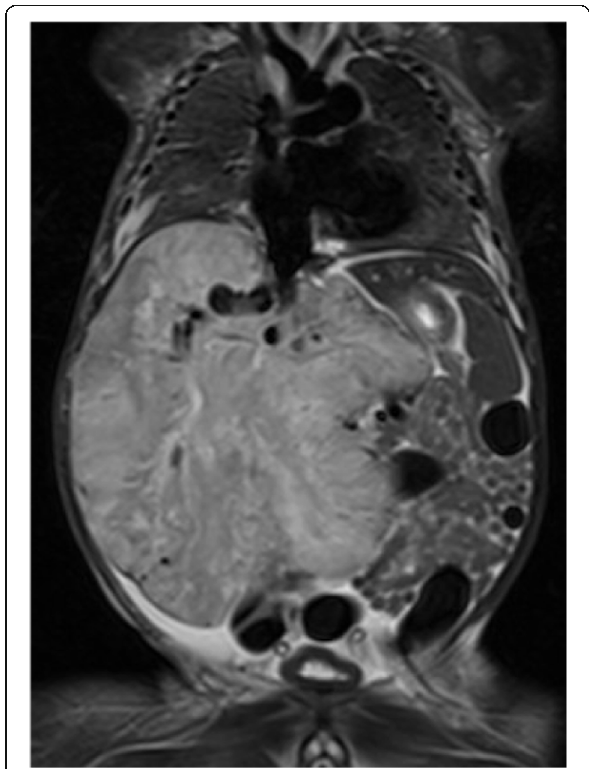
Fig. 3 Coronal T2 weighted MR image, showing a large rapidly- involuting congenital haemangioma (RICH) occupying almost all of the liver in a 3-day old male. The lesion caused splinting of the diaphragm, high output cardiac failure and abdominal compartment